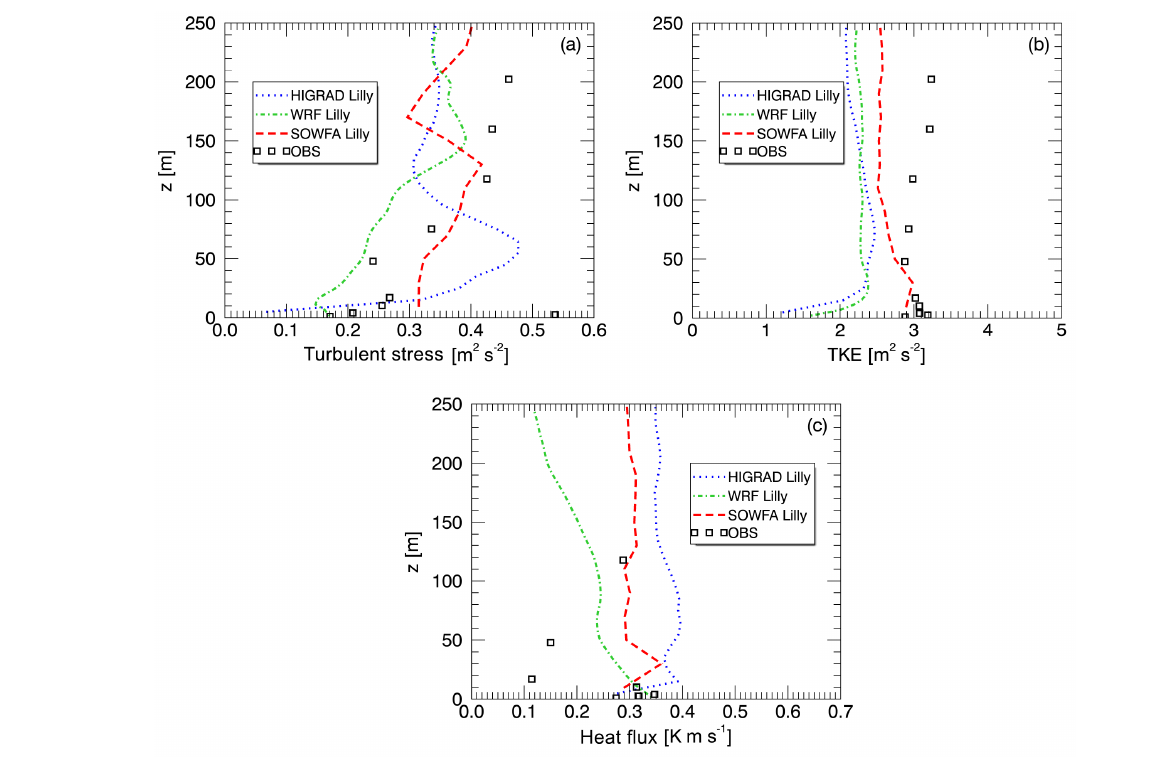
Figure 16. Simulated and measured TKE (a) , turbulent stress (b) , and sensible heat flux (c) from the convective case study.